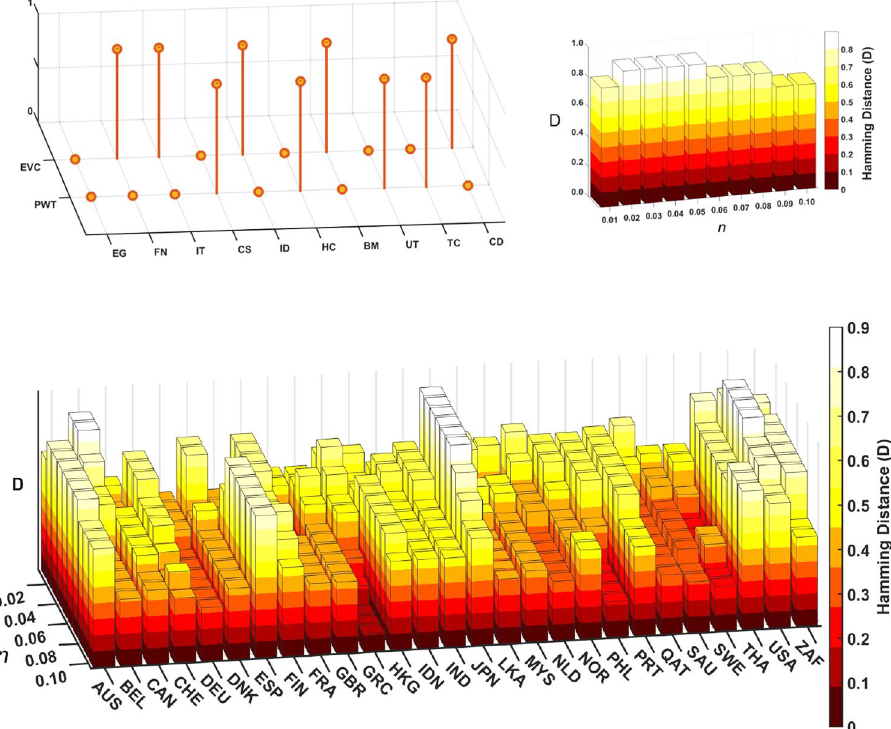
Figure 7. Upper Left : Relationship between the bit-strings of sectoral centralities (EVC) and their corresponding inclusion in the portfolio (PWT) for the different sectors of the USA. The threshold values θ e and θ p (as 2% of the coefficient of variations of EVC and PWT, respectively) would determine, whether the sector is central or not (EVC is 0 or 1), or whether the corresponding sector would appear in the optimal portfolio or not (PWT is 0 or 1). Upper Right : The Hamming distance D computed from the bit-strings EVC and PWT for USA, against the different values of n (percentage) of the coefficient of variations of EVC and PWT, respectively, which determine the threshold values θ e and θ p . Lower : The Hamming distance D computed from the bit-strings EVC and PWT, against the different values of n (percentage), for the different countries, plotted as a